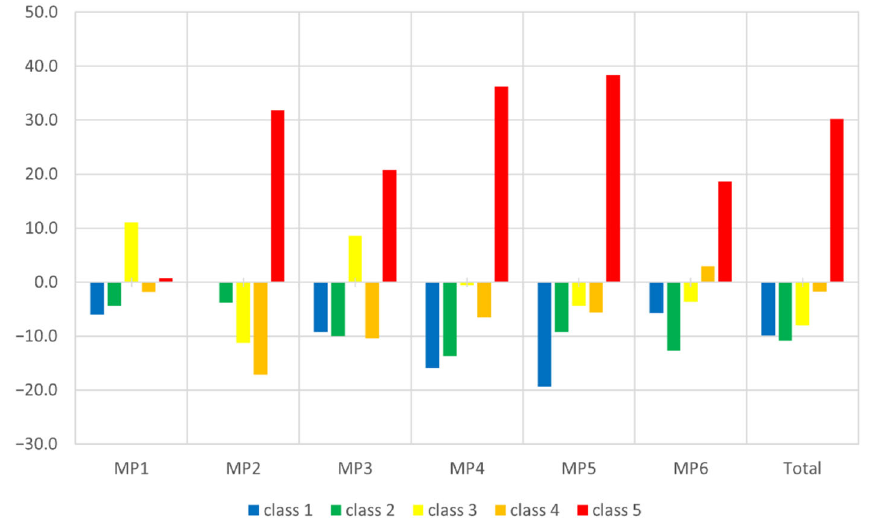
Figure 4. Difference [%] of the evaluation classes (1–5) of the Hase River between the Lower Saxonian Mountains (river type 6) and the Northwestern Lowlands (river type 15 and 15_g). MP1 = river development, MP2 = longitudinal section, MP3 = cross-section, MP4 = river bed structure, MP5 = bank structure, MP6 = watercourse environment, total = total evaluation. The middle course was not considered.